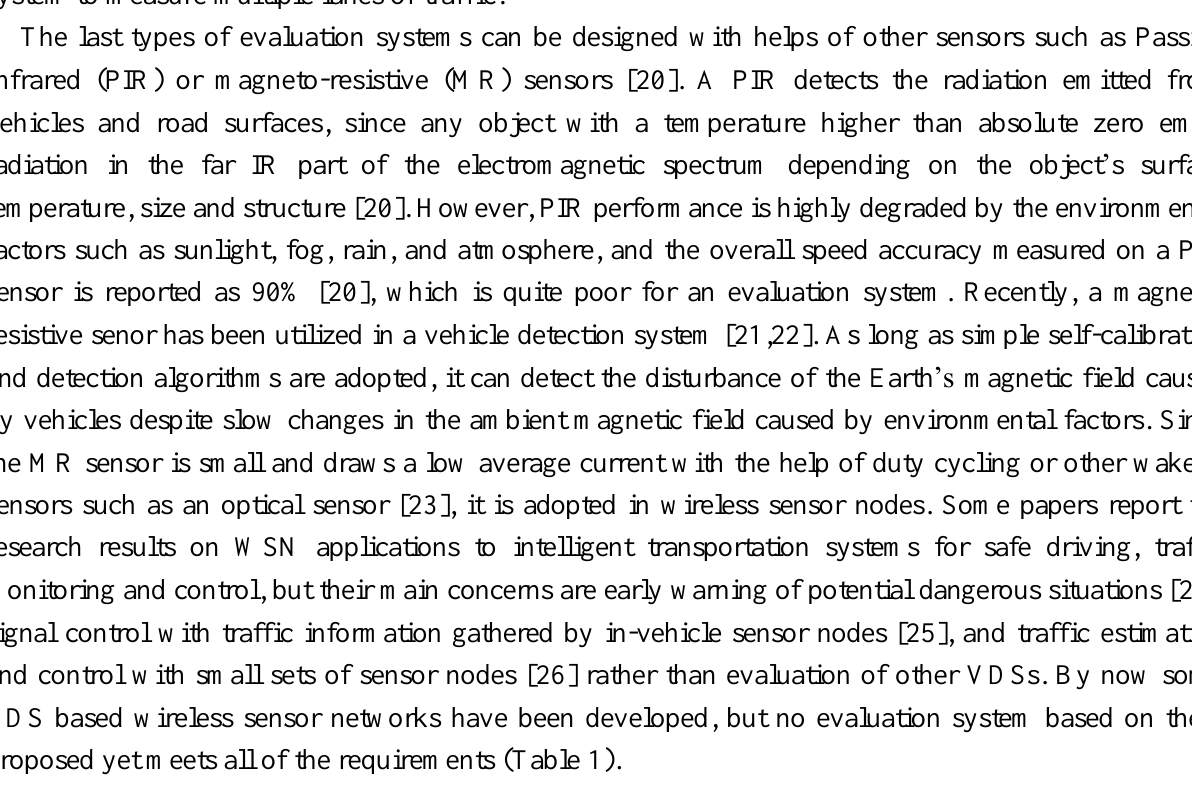
Table 2. Overall comparison between the existing portable evaluation systems (or VDSs) and